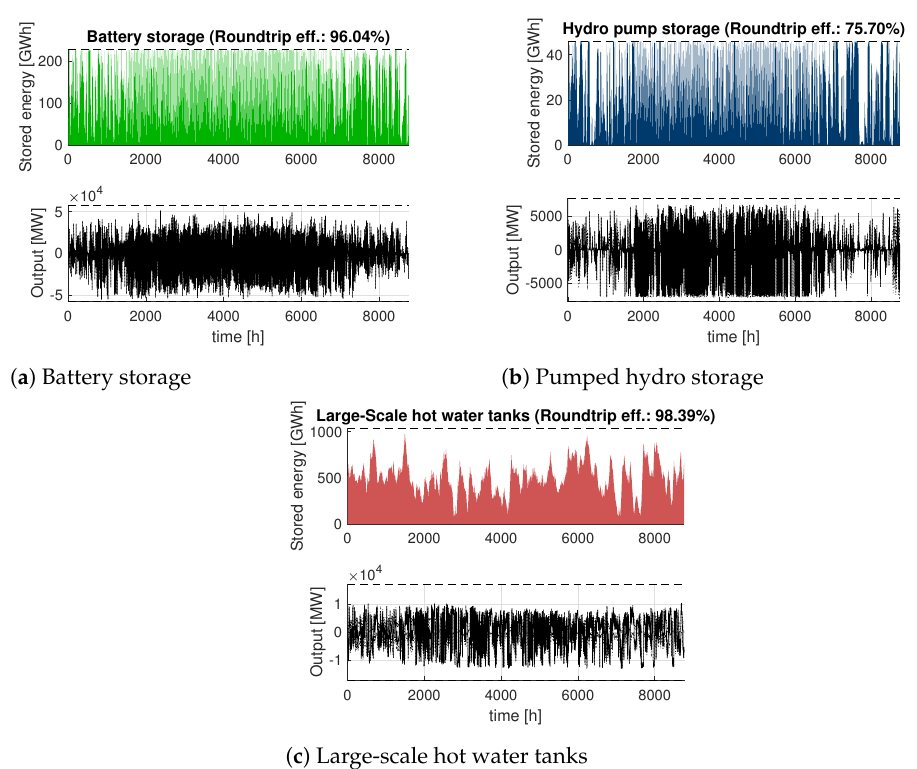
Figure 17. Stored energy and energy input/output in scenario BOTH. The shown patterns do not vary significantly per scenario, only the magnitude of heat storage changes according to